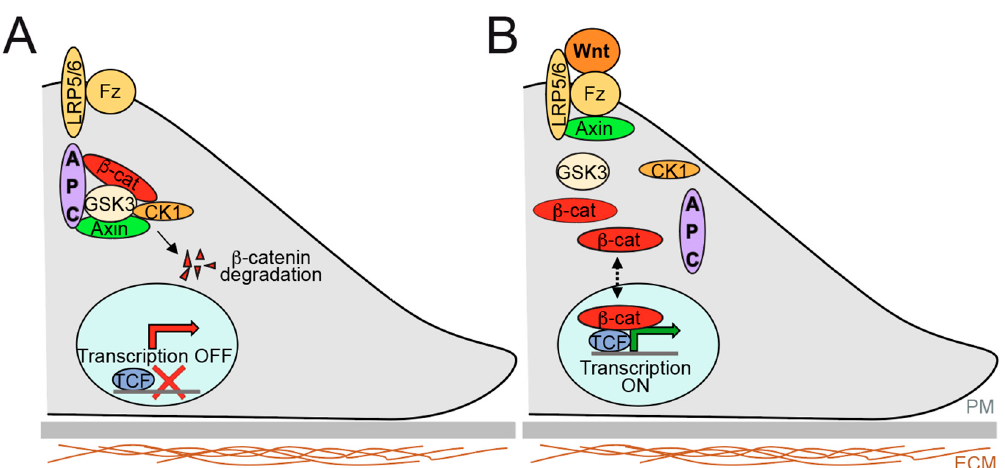
Figure 4. General view of Wnt signalling pathway. ( A ) In absence of Wnt signalling, APC forms a ’destruction complex’ with Axin, Casein Kinase (CK1), Glycogen Synthase Kinase 3 (GSK3) that leads to hyperphosphorylation of beta-catenin, and consequently degradation. ( B ) Wnt stimulation leads to the inactivation and / or dissociation of the destruction complex. In this case, Wnt ligand binds to a Frizzled (Fz) / LRP5 / 6 cell-surface receptor complex. This Wnt complex leads to stabilisation of hypophosphorylated beta-catenin, which enters the nucleus and interacts with transcription factors (TCF / LEF proteins) to activate gene transcription. PM: Plasma membrane. ECM: Extracellular matrix.